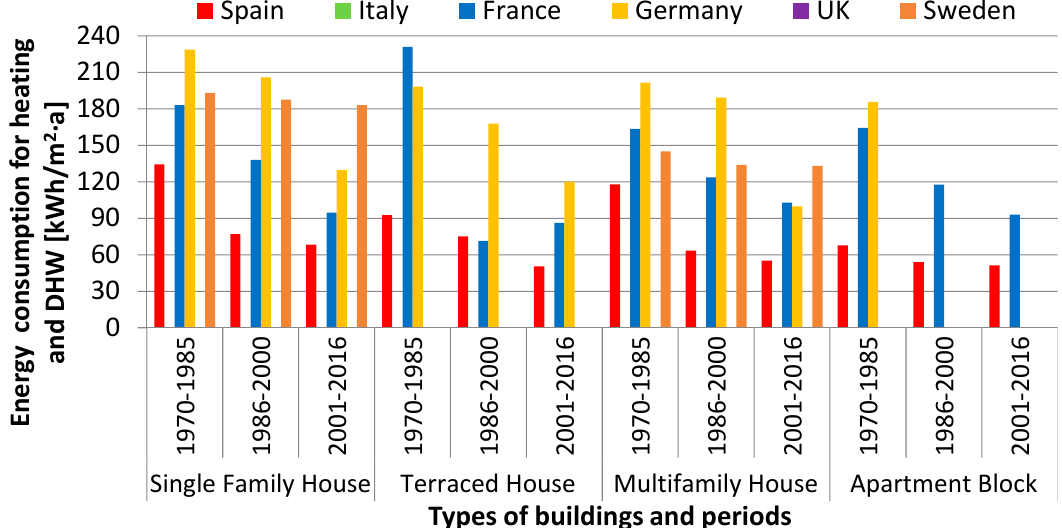
Figure 7. Energy consumption for heating and domestic hot water in cold climate conditions by country.